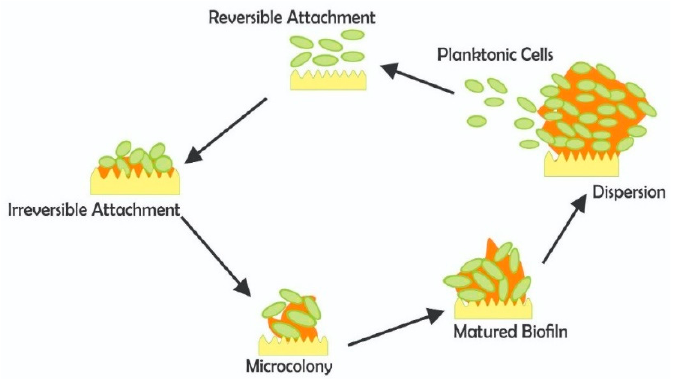
Figure 4. Schematic illustration of different phases in biofilm microbiology.